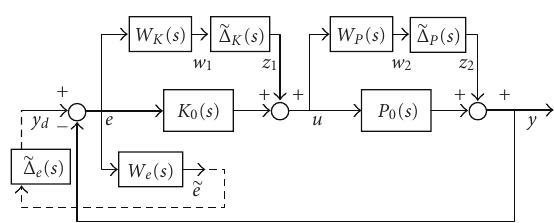
Figure 2: Expanded control loop with additive uncertainties and fictitious performance